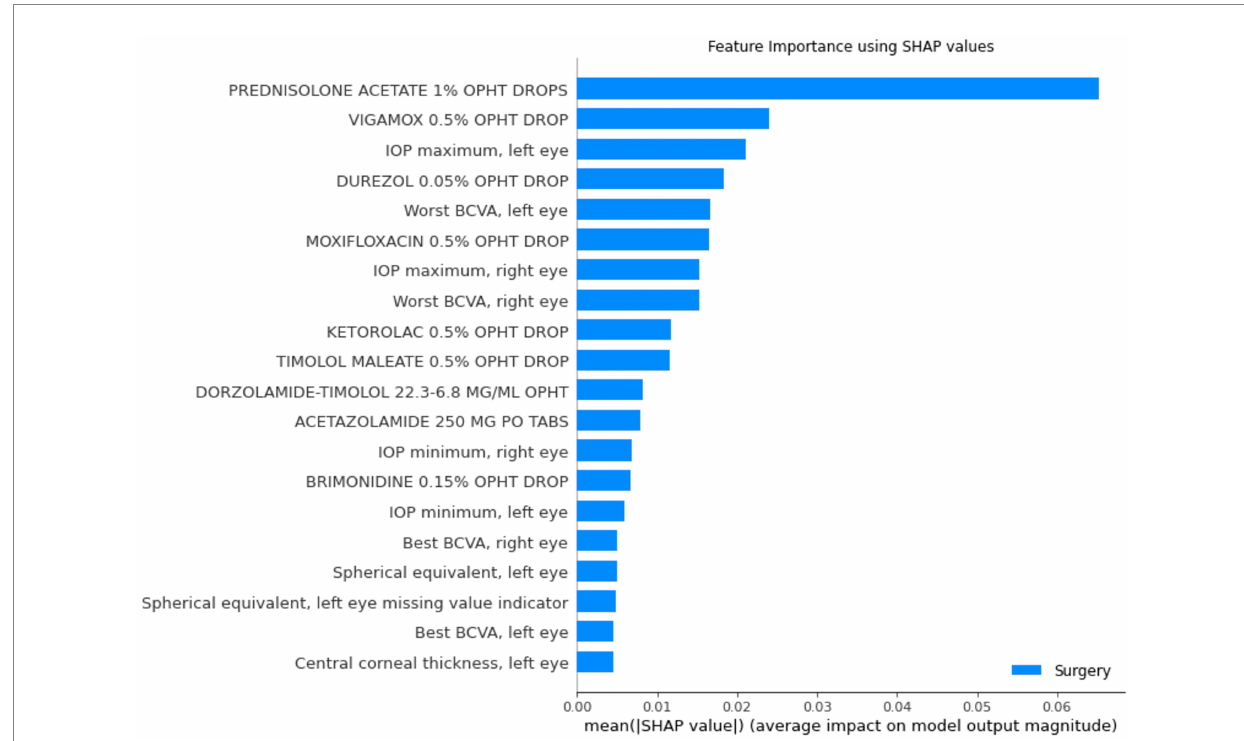
FIGURE 6 Shapley feature importance for structured data. The figure depicts the mean absolute Shapley value for the top 20 most important features in the structured data for predicting whether a patient would progress to the point of requiring surgery within the next year, using the random forest model. The mean absolute Shapley value was calculated for all patients in the test set.